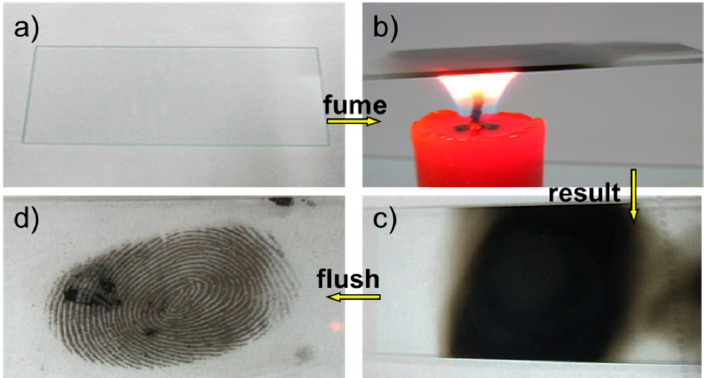
Figure 1. A general protocol of the candle soot coating (CSC) method: ( a ) A latent fingermark